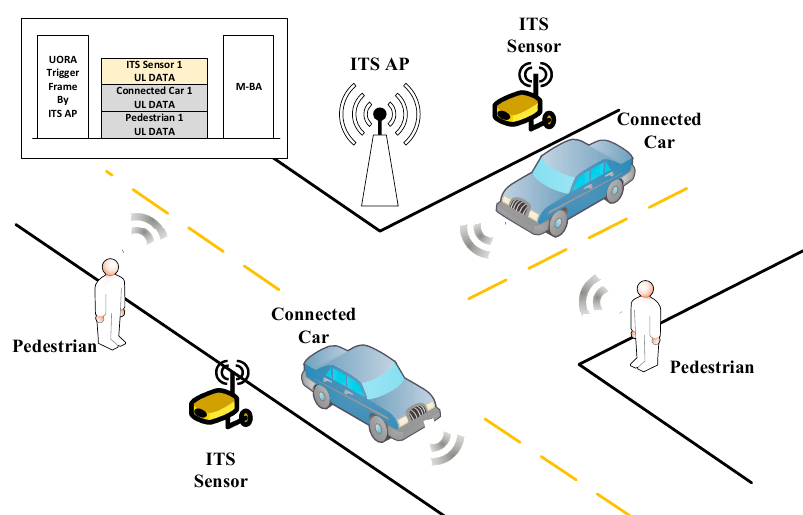
Figure 1. A sample scenario of the next-generation vehicle-to-anything (V2X) system components. ITS, intelligent transport system; AP, access point.